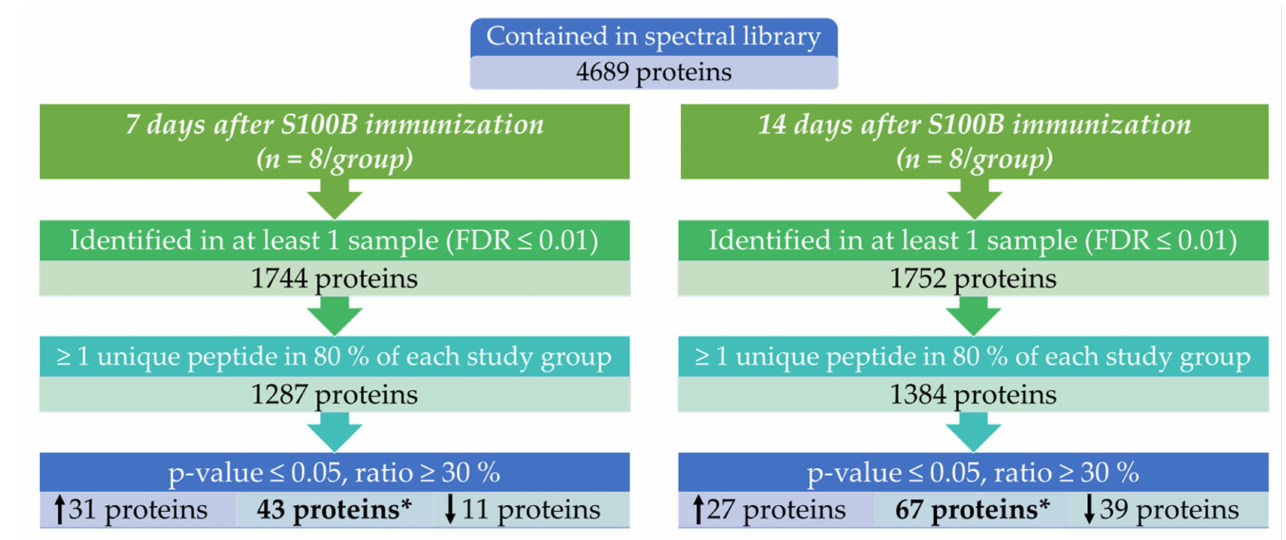
Figure 2. Flow chart of identified and filtered proteins for study groups at 7 as well as 14 days after S100B immunization ( n = 8/group). * One protein showed both an up-regulated as well as a down-regulated peptide, compared to the control